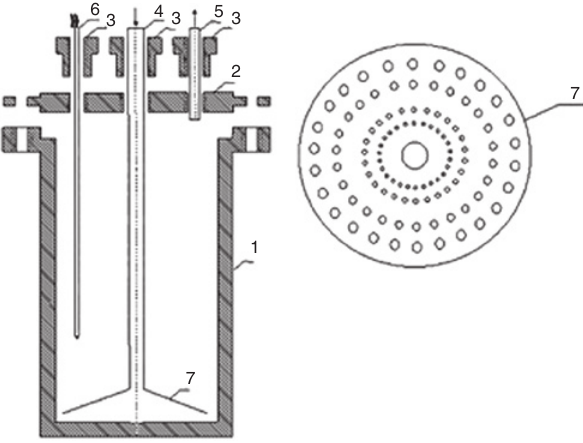
Figure 1: Design of the reactor used: 1 – reactor vessel, 2 – top (sealing flange), 3 – sealing nuts, 4 – gas inlet, 5 – gas outlet, 6 – thermocouple, 7 – Buchner